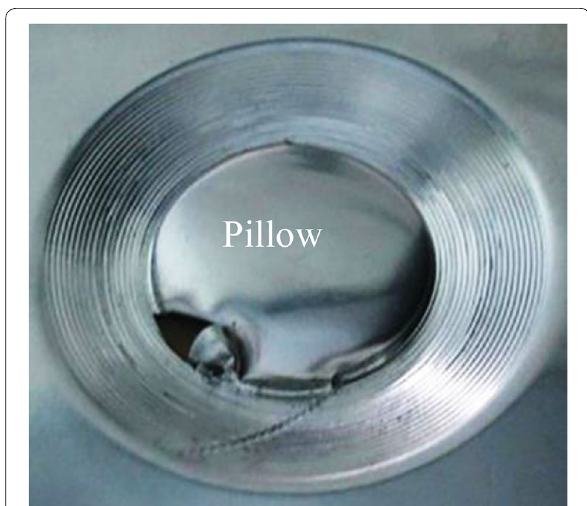
Figure 7 Rupturing of sheet material due to pillowing during forming a shallow part using an unduly small tool (’R